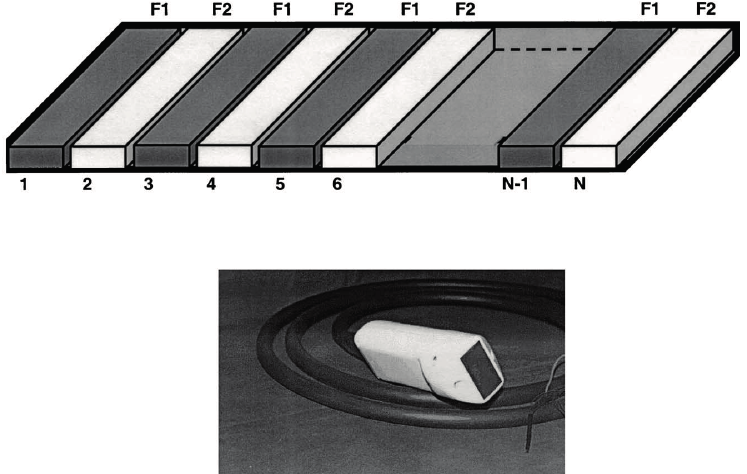
Figure 1. Schematic of the first design incorporating dual-frequency transducers for the purpose of contrast detection ( top ). Odd numbered elements had a center frequency of 2.8 MHz with a fractional bandwidth of 80% while the even elements had a center frequency of 0.9 MHz with a fractional bandwidth of 50%. Odd numbered elements were used for imaging superharmonics generated by nonlinear vibrations of microbubbles excited with a low-frequency pulse provided by the even elements. A photograph of the actual transducer is shown after the elevational lens has been added ( bottom ). Figure reprinted with permission from